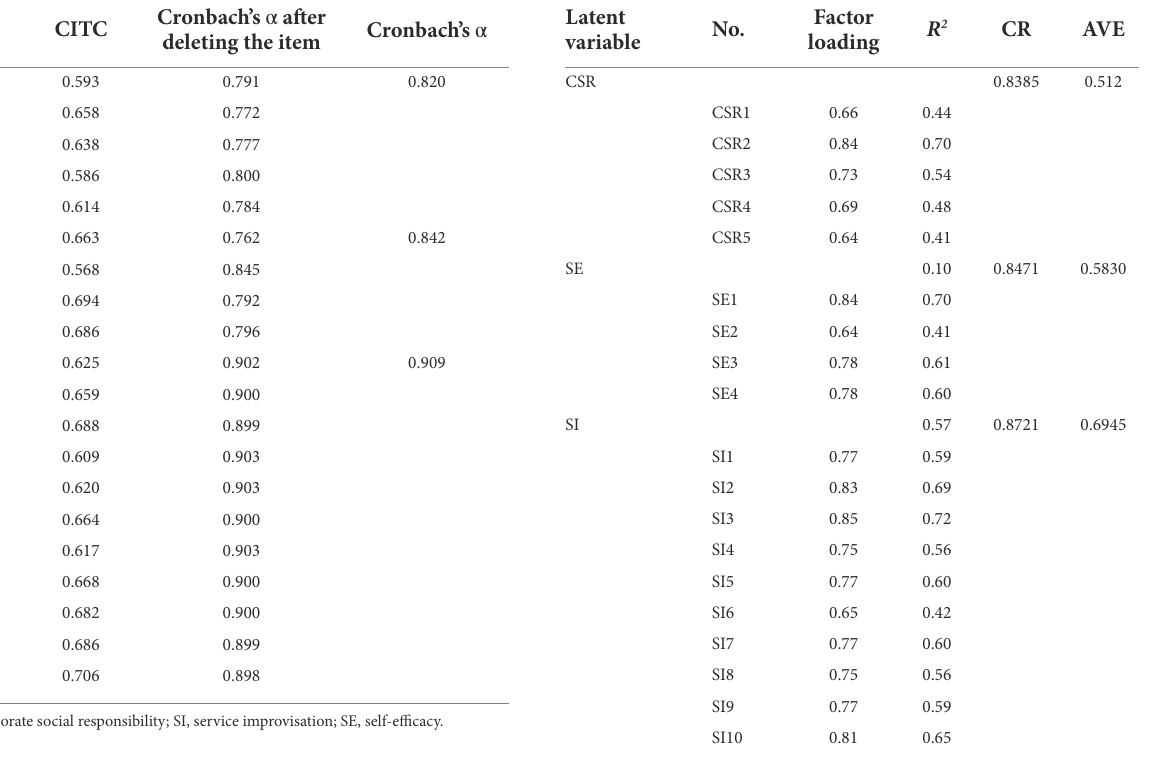
TABLE 3 Reliability analysis. TABLE 4 The results of the confirmatory factor